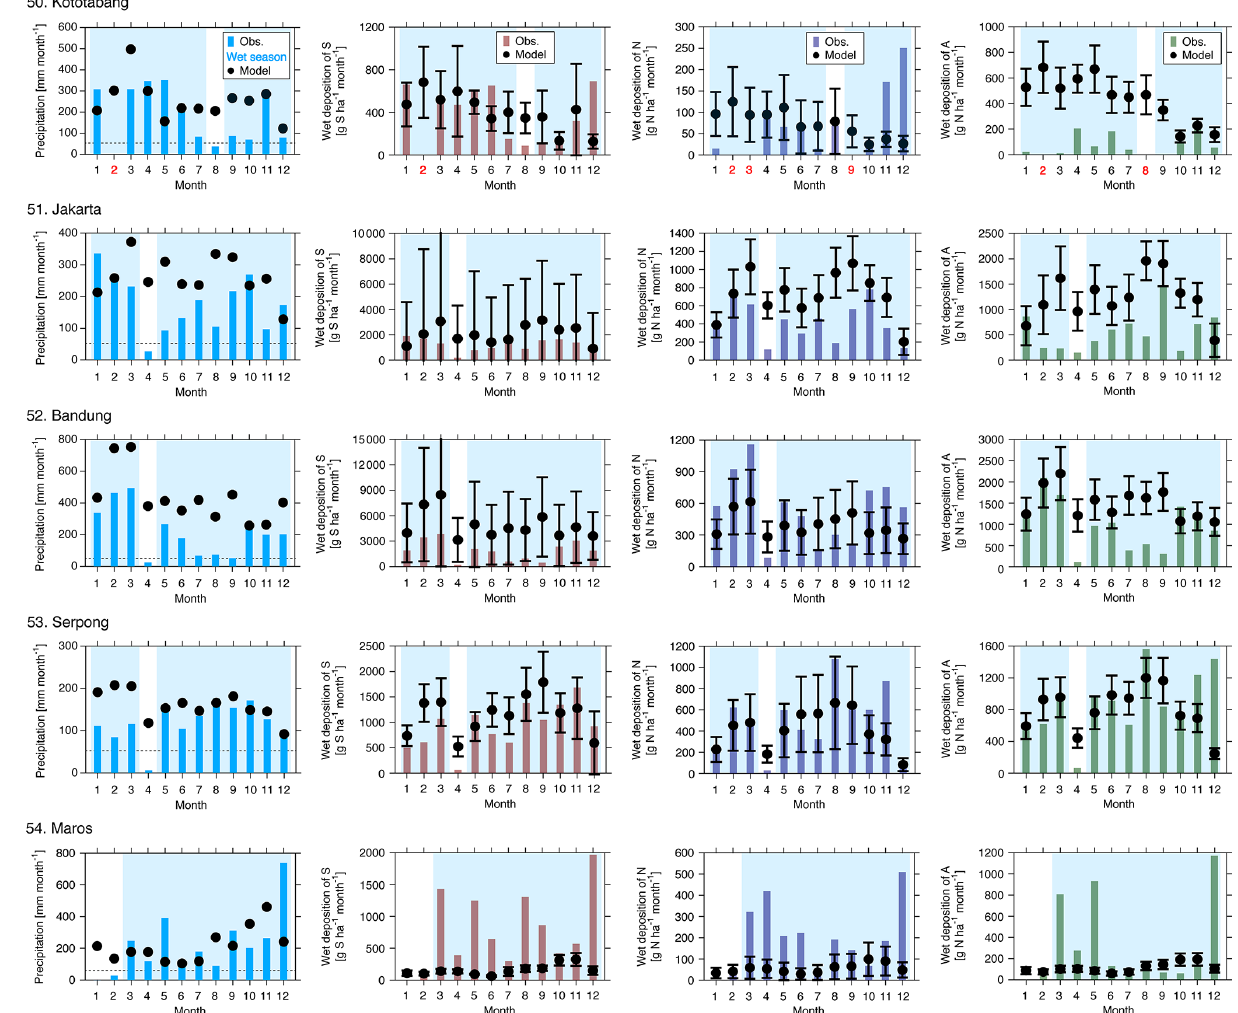
Figure 8. Monthly accumulated precipitation and wet depositions of S, N, and A over Indonesia. Whiskers represent the standard deviation among the seven models, and the wet season (light blue color) is defined as months when precipitation exceeded 50mm. Months shown in red indicate a lack of observational data. Table 9. Statistical analysis of model performance for five sites in